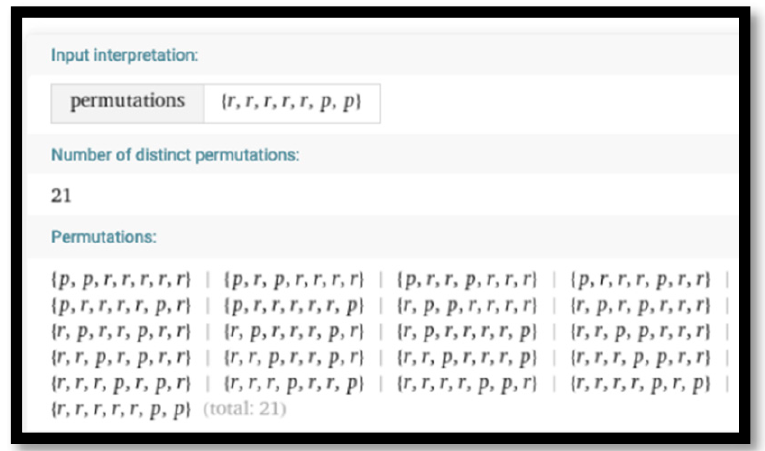
Figure 8. Answering the question asked by the second grader by permuting letters in a word.